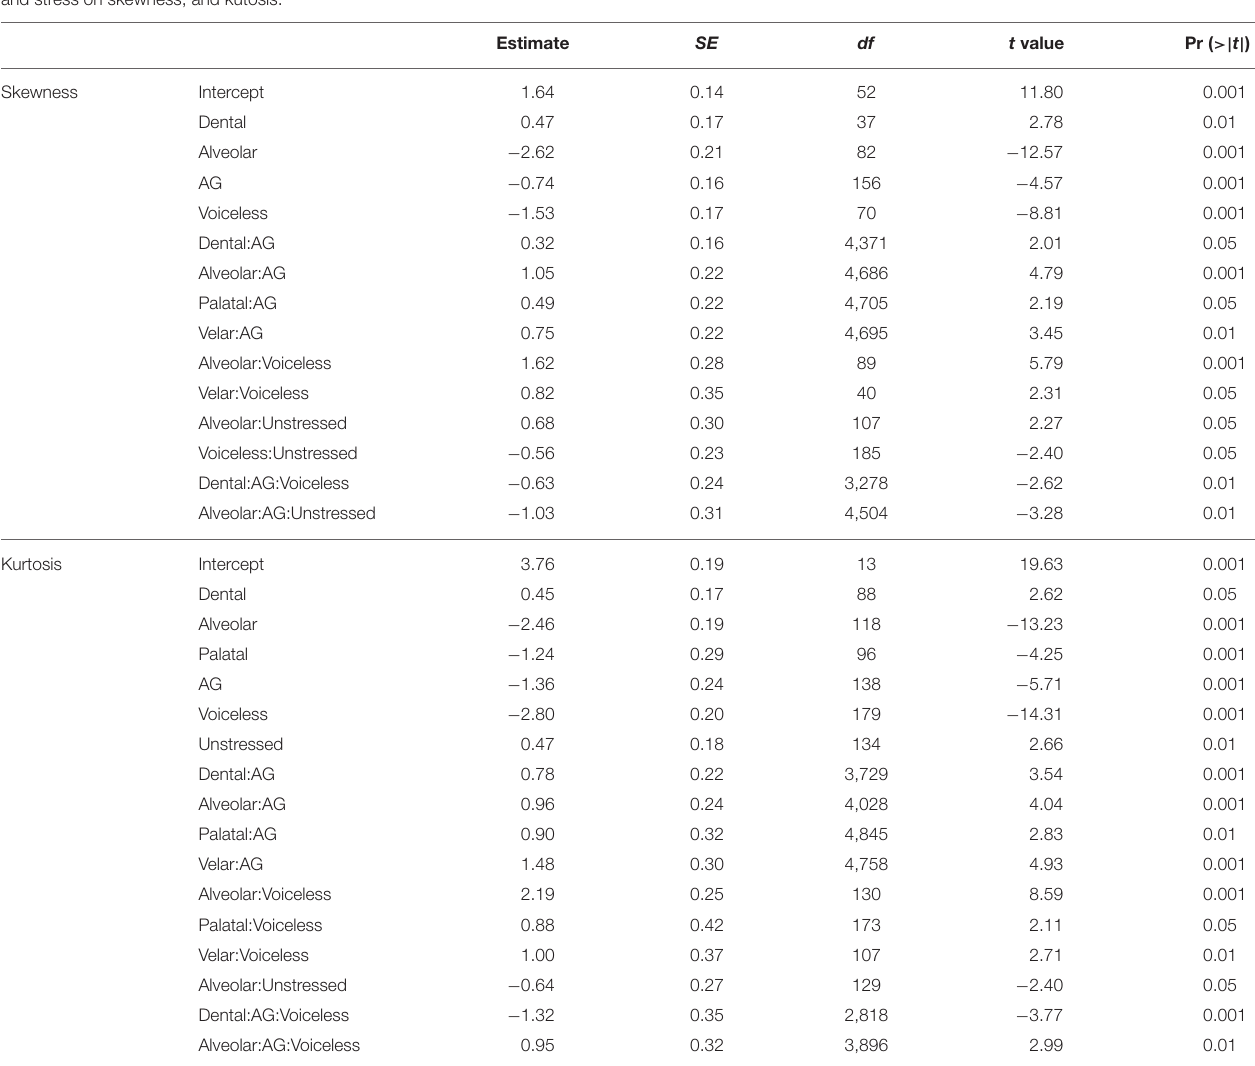
TABLE 5 | Results from the linear mixed effects models for the effects of the effects of dialect [Athenian Greek (AG) and Cypriot Greek (CG)], place of articulation, voicing, and stress on skewness, and